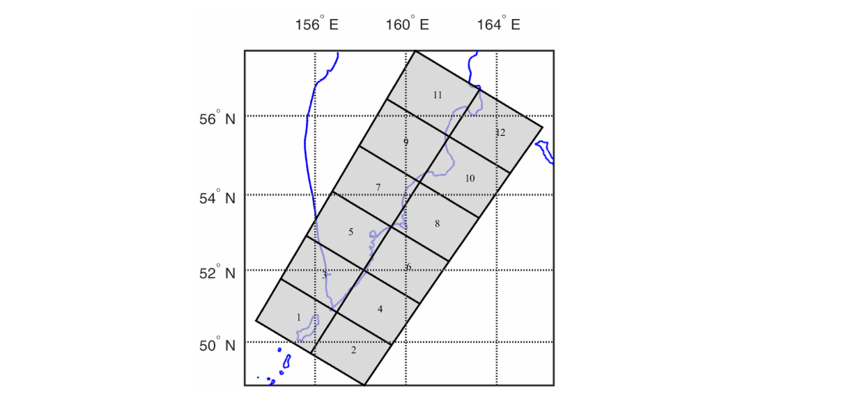
Figure 1. Division of the studied seismic area S into unit cells S i with dimensions of 150 × 200 km.